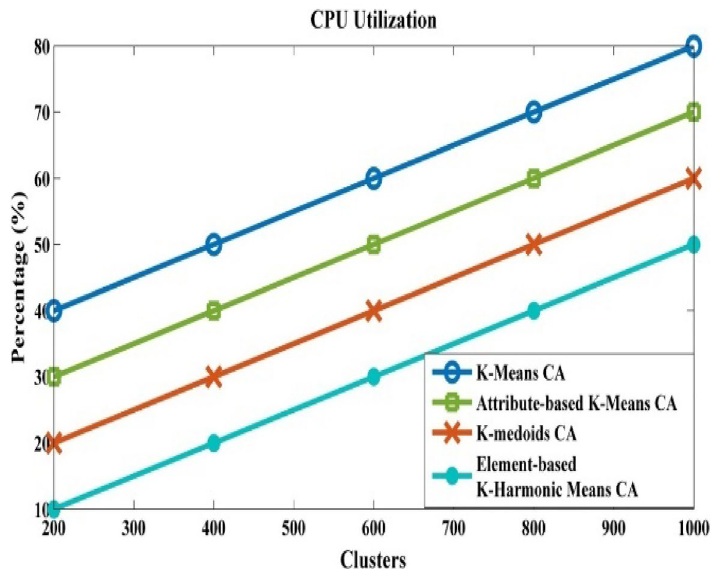
Figure 10. CPU utilization.